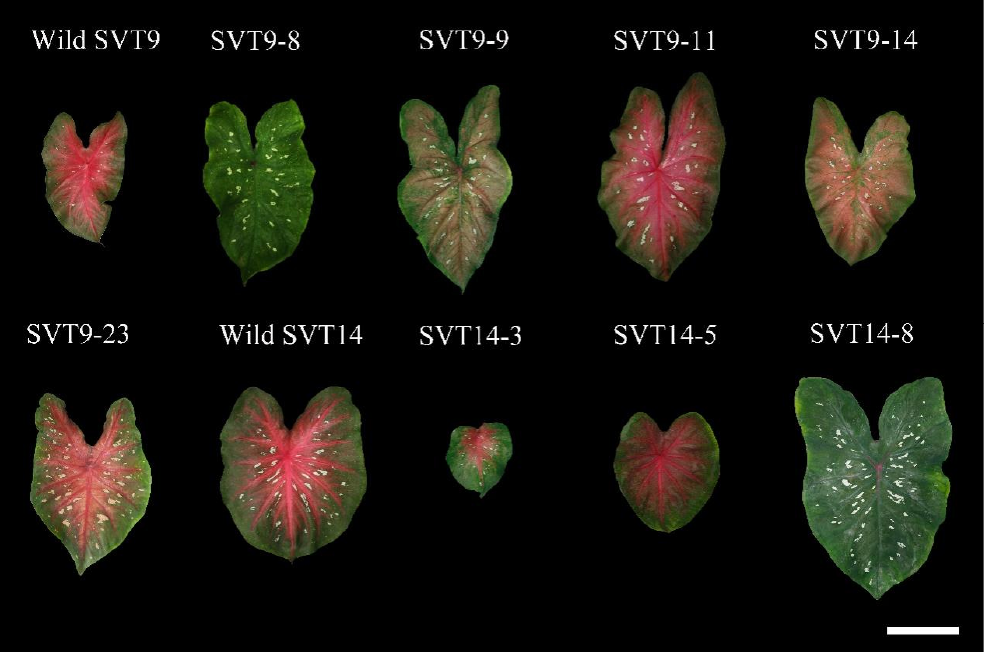
Figure 2. Typical leaves of the variants regenerated from the SVT9 and the SVT14 in vitro and their corresponding wild-type parent. The photos were taken 4 months after the plants were grown in plastic pots filled with a commercial potting mix and grown in a greenhouse. Scale bar: 5 cm. Table 1. Main foliar characteristics of the variants regenerated from two types of caladium aneuploids (SVT9 and SVT14) in vitro and their corresponding parent grown in plastic pots for 4